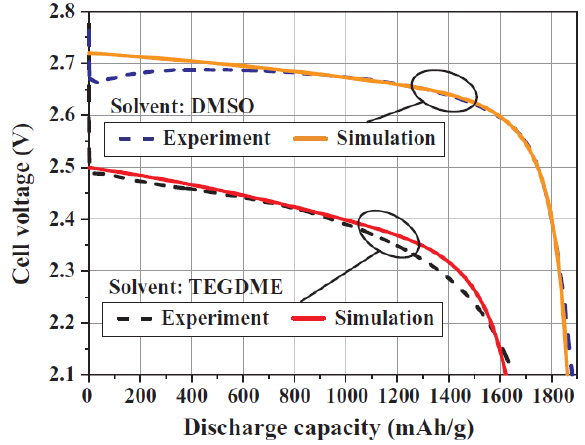
Figure 17. Simulated discharge curves for TEGDME and DMSO electrolytes in comparison with experiments. The discharge current density is 4 A · m 2 . Republished from Xue et al. [11] with permission of The Electrochemical Society, conveyed through Copyright Clearance Center, Inc.